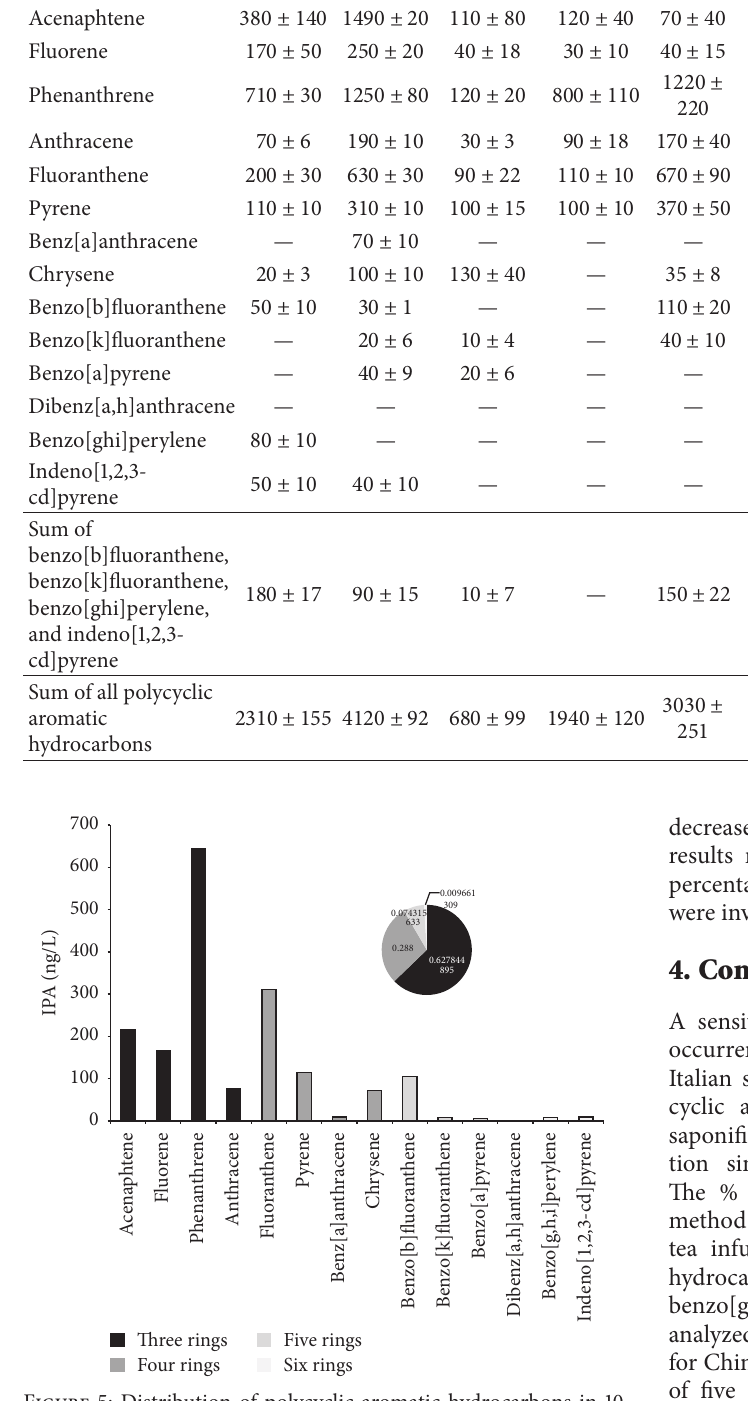
Figure 5: Distribution of polycyclic aromatic hydrocarbons in 10 Italian commercial black tea